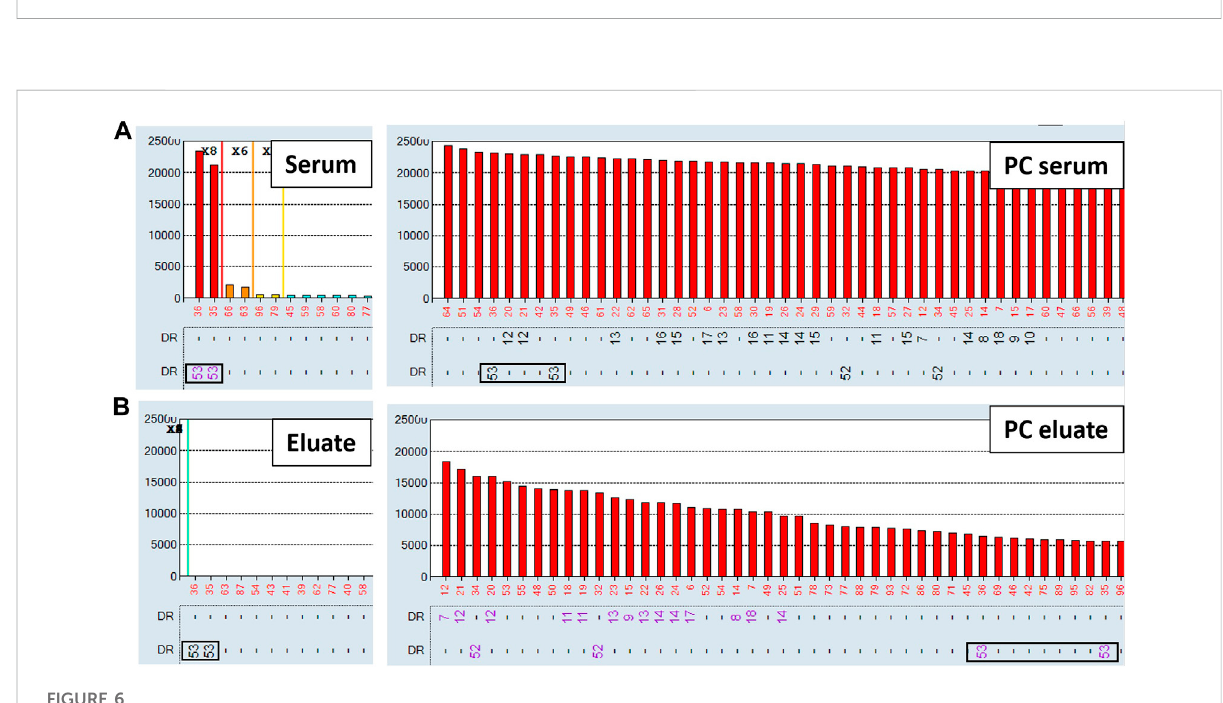
from a highly sensitized renal transplant candidate relisted a few years after failing his fi rst deceased donor transplant. Single antigen beads corresponding to patient ’ s own HLA typing and